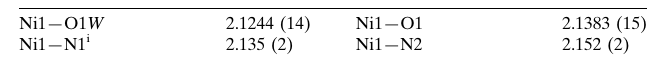
Selected bond lengths (A˚ ).